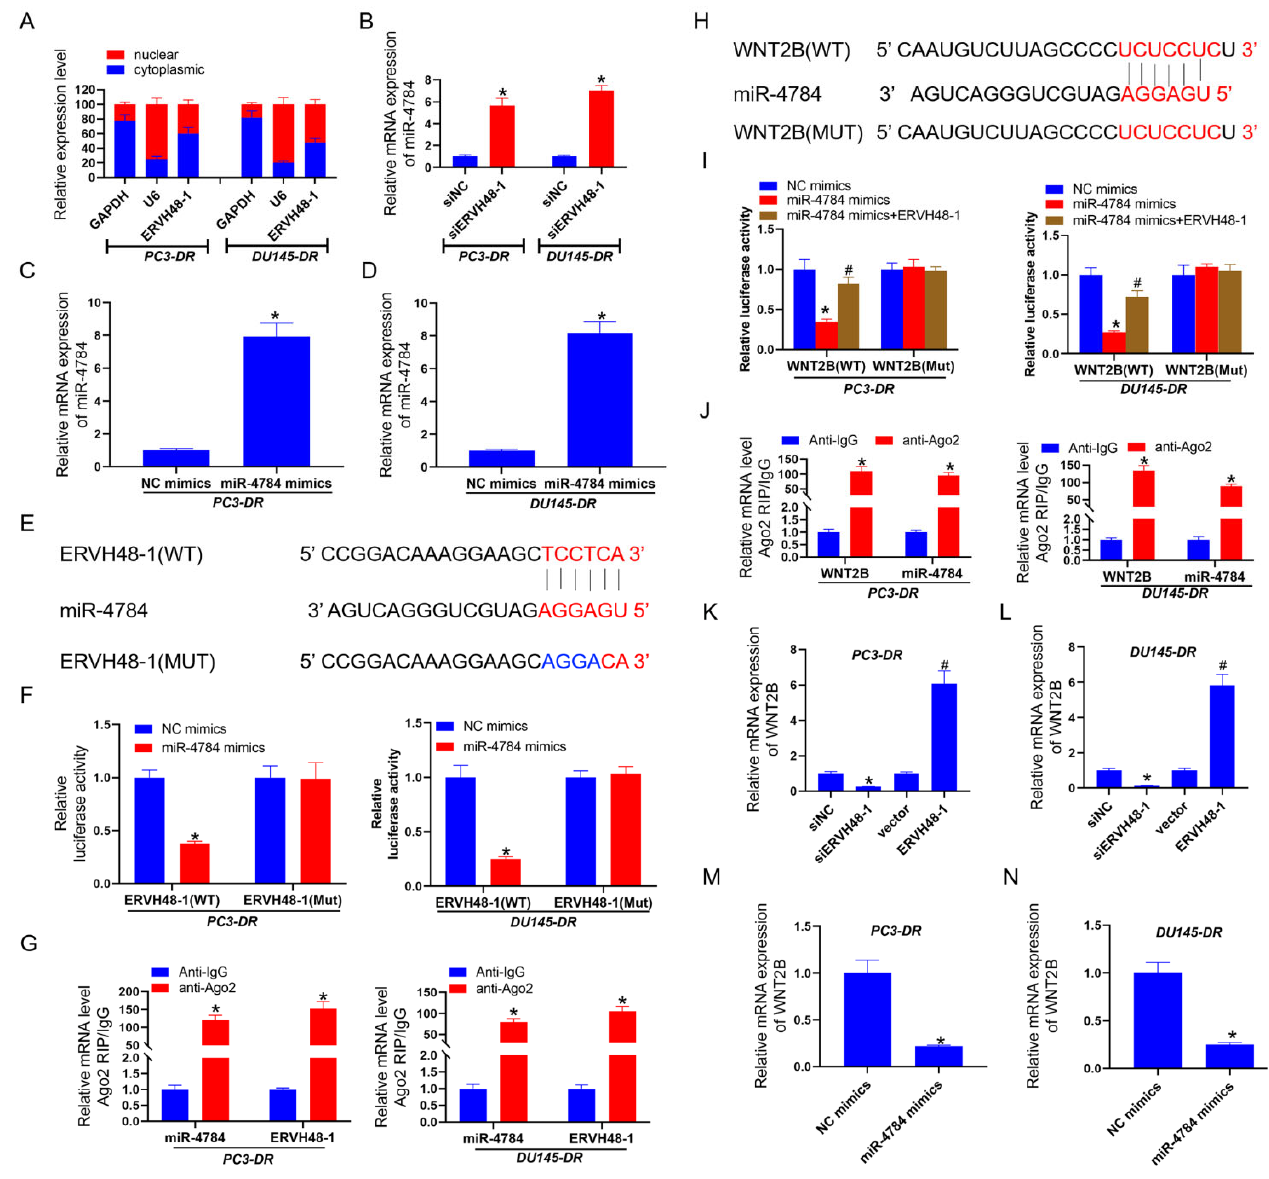
Figure 8. ERVH48 ‐ 1 increased the expression of WNT2B by suppressing miR ‐ 4784. ( A ) The location Figure 8. ERVH48-1 increased the expression of WNT2B by suppressing miR-4784. ( A ) The location of ERVH48 ‐ 1 was discovered in PC3 ‐ DR and DU145 ‐ DR cells. ( B ) RT ‐ PCR quantification of